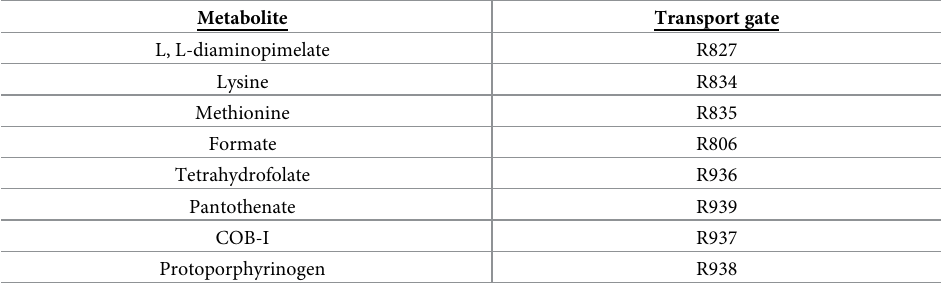
Table 1. Essential in silico medium supplements and their transport gates in